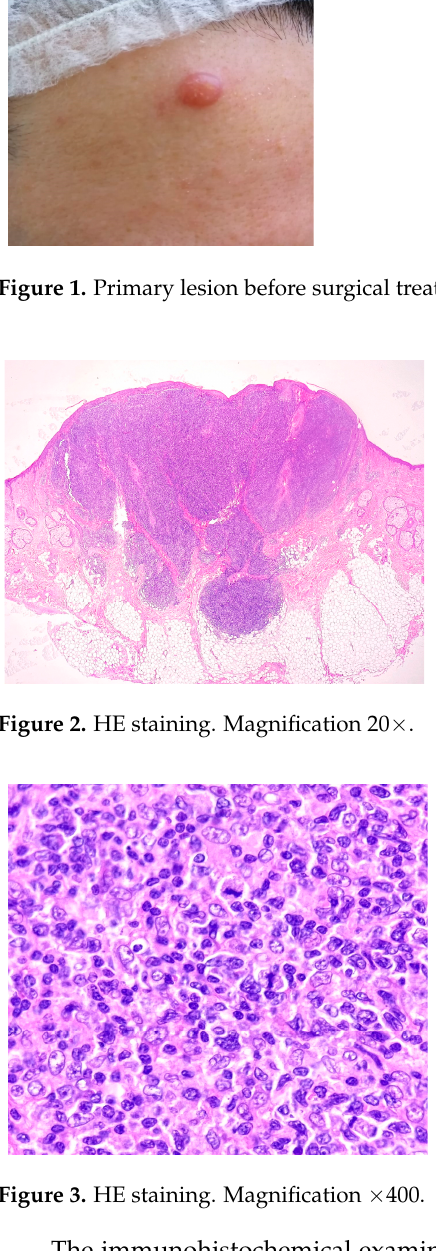
Figure 1. Primary lesion before surgical treatment.